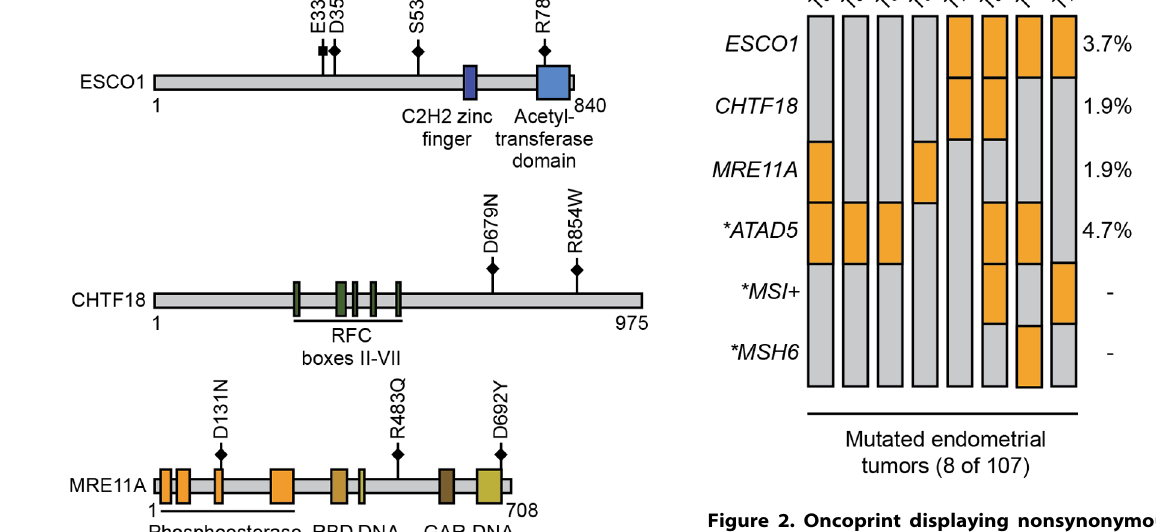
Figure 2. Oncoprint displaying nonsynonymous somatic mu- tations in ESCO1 , CHTF18 , MRE11A , and ATAD5 in eight primary endometrial cancers. Individual tumors (T) are indicated by vertical gray bars. Tumors consist of NEECs (T3, T51, T62, T68, T77, T79, T113) and an EEC (T88). Genes (left) and nonsynonymous somatic mutations (orange boxes) are indicated. ESCO1 , CHTF18 , and MRE11A were analyzed in this study; * ATAD5 mutations, MSH6 mutations, and microsatellite instability (MSI) have previously been described else- where [44], [52].